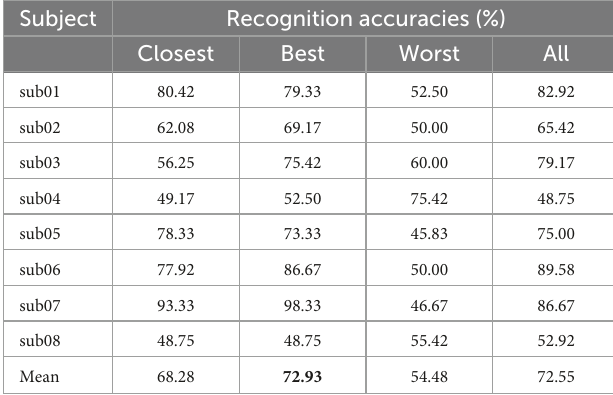
TABLE 2 The performance of the different strategies in the cross-subject test in